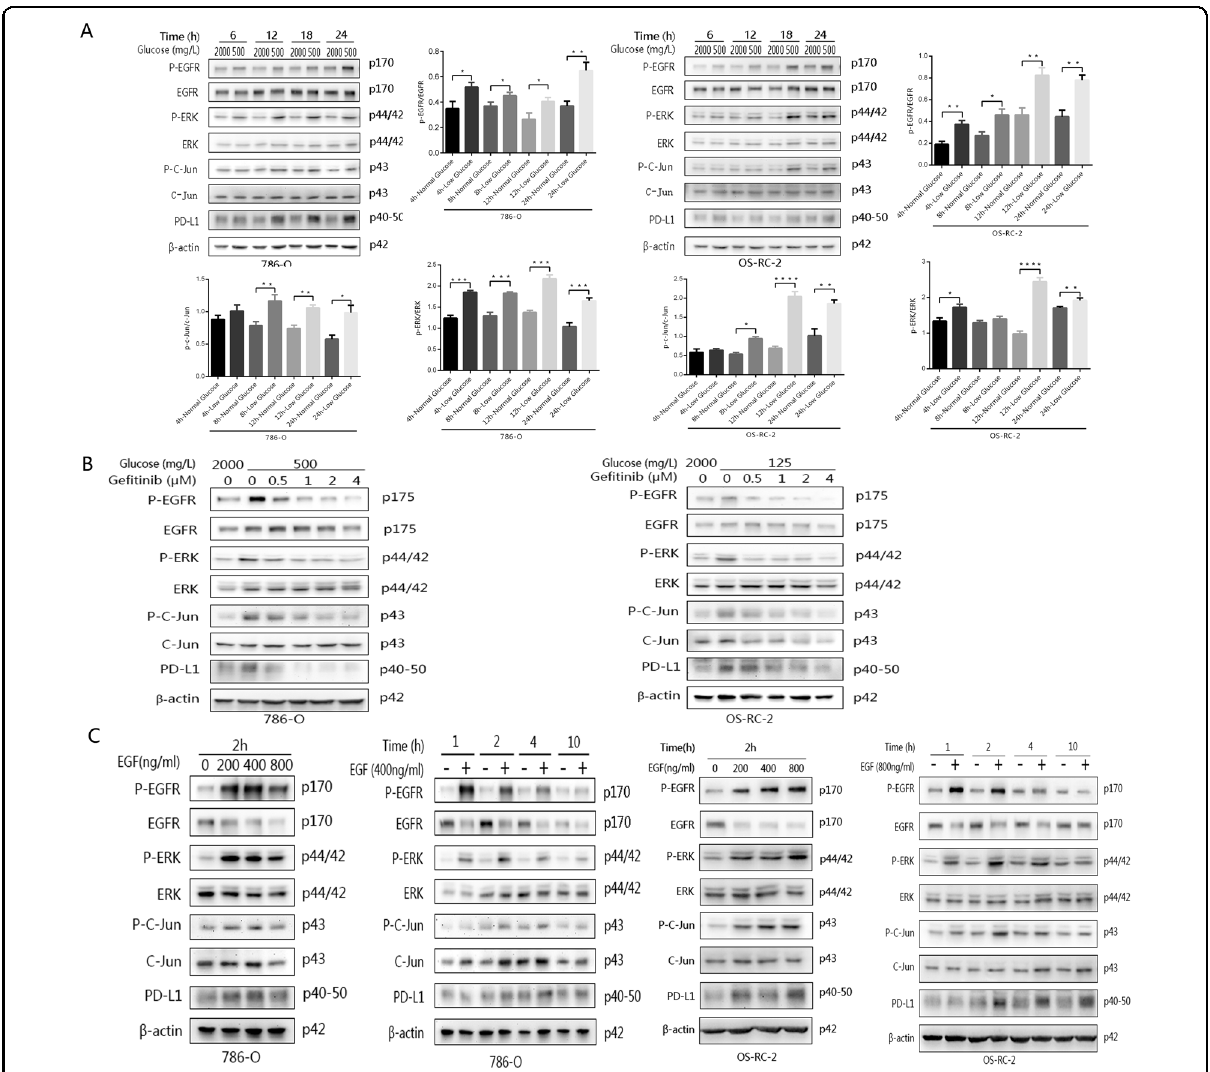
Fig. 4 The protein levels of EGFR, ERK, c-Jun and PD-L1 induced in the two cell lines were detected by western blot analysis after treatment with different intervention conditions for 24 h. A The expression levels of the various target proteins mentioned above at different time points under low-glucose conditions. B The expression levels of the target proteins after the EGFR inhibitor ge fi tinib was added under low- glucose conditions. C The expression levels of the target proteins after the EGFR activator EGF was added under low-glucose conditions. Independent experiments were performed in